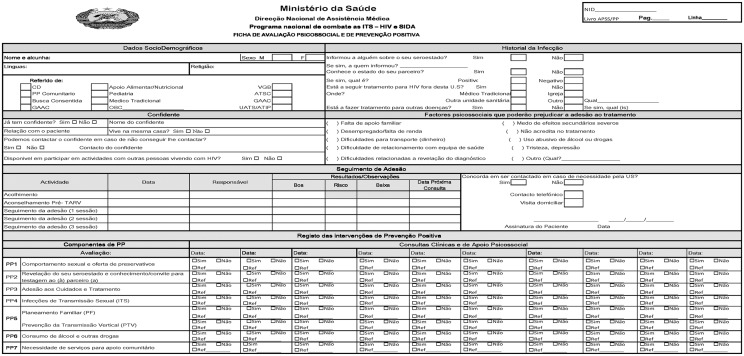
Psychosocial Evaluation and Positive Prevention form.